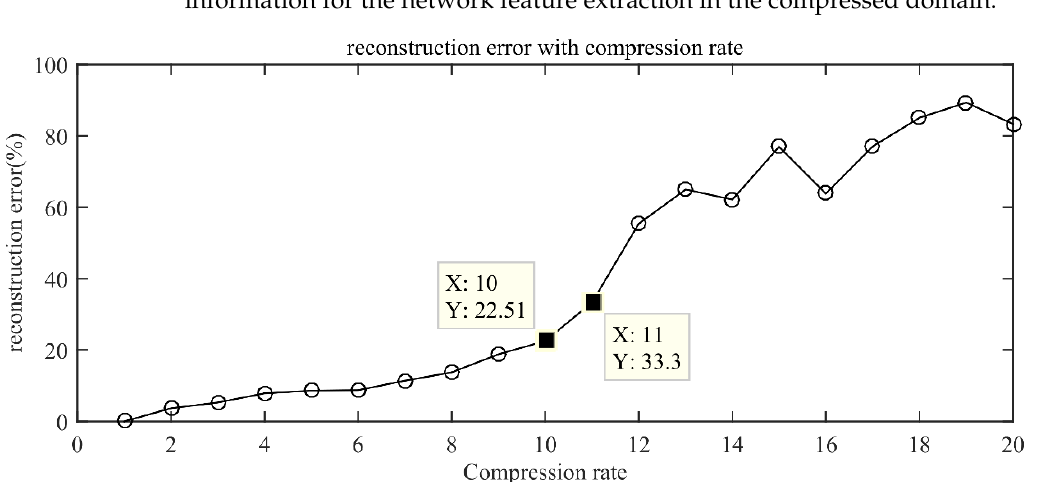
Figure 5. Reconstruction error curve under different compression rates.